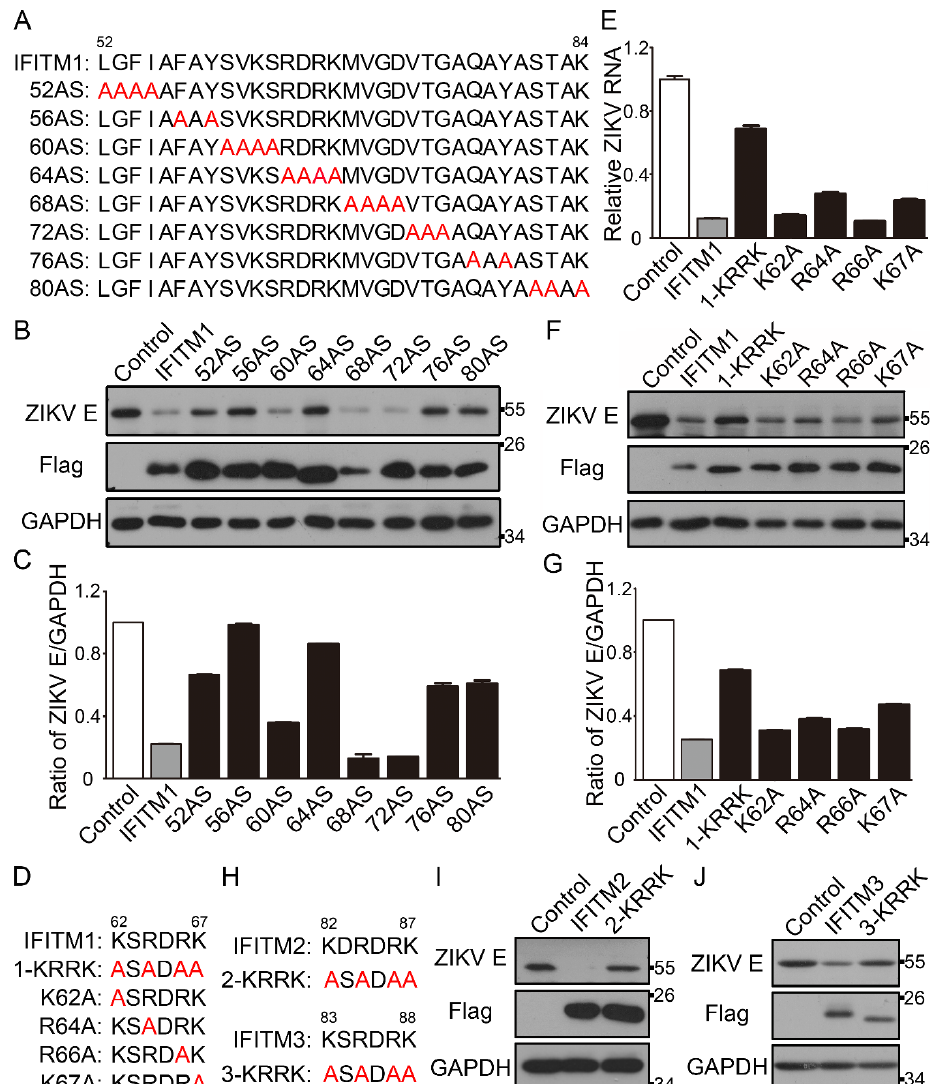
Figure 3. The antiviral functional residues analysis of IFITM1 / 2 / 3 against ZIKV. ( A ) Eight alanine scan (AS) mutants of IFITM1. Each AS mutant is named for the first of four sequential residues that have been substituted with alanines (marked red). ( B , C ) The inhibitory e ff ect of IFITM1 and AS mutants of IFITM1 on ZIKV replication. pcDNA3.1, pcDNA3.1-Flag-IFITM1 and AS mutants of pcDNA3.1-Flag-IFITM1 were transfected in Vero cells, respectively. After 24 h, cells were infected with ZIKV (MOI = 0.1). After 48 h, cells were collected, and the intracellular expression level of ZIKV E protein was analyzed by Western blotting ( B ). Grayscale of figure B was analyzed with Image J software ( C ). ( D ) The KRRK mutant and single point mutants of IFITM1. ( E – G ) The inhibitory e ff ect of IFITM1 and mutants of IFITM1 on ZIKV replication. pcDNA3.1, pcDNA3.1-Flag-IFITM1 and mutants of pcDNA3.1-Flag-IFITM1 were transfected in Vero cells, respectively. After 24 h, cells were infected with ZIKV. After 48 h, cells were collected, and the relative intracellular ZIKV RNA was analyzed by qPCR ( E ), and the expression level of intracellular ZIKV E protein was analyzed by Western blotting ( F ). ( G ) Grayscale of figure F was analyzed with Image J software. ( H ) The KRRK mutants of IFITM2 and IFITM3. ( I , J ) The inhibitory activity of IFITM2 / 3 and their mutants against ZIKV replication. pcDNA3.1-Flag-IFITM2 and mutant of pcDNA3.1-Flag-IFITM2 ( I ), pcDNA3.1-Flag-IFITM3 and mutant of pcDNA3.1-Flag-IFITM3 ( J ), were transfected in Vero cells, respectively. After 24 h, cells were infected with ZIKV. After 48 h, cells were collected and the intracellular expression level of ZIKV E protein was analyzed by Western